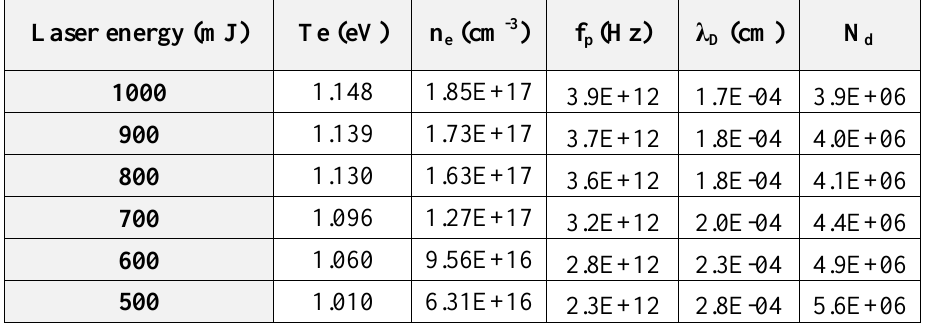
Table 1: Plasma parameters for CuO:Pb at X=0.6 in Vacuum with different laser energy. Laser energy (mJ)